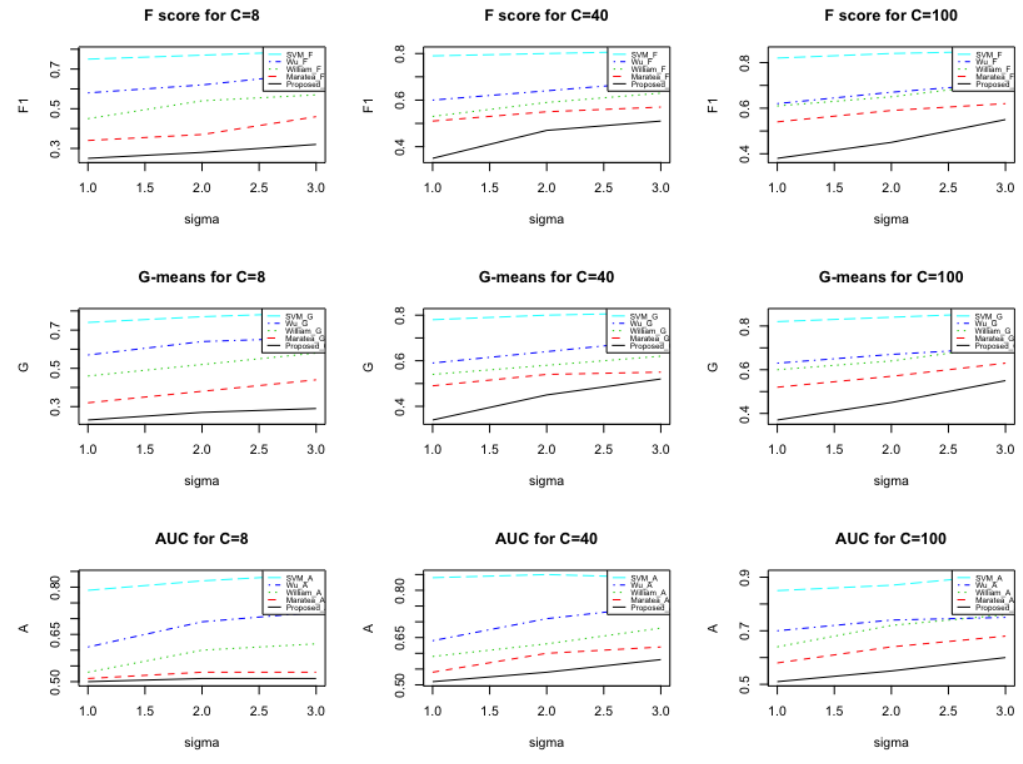
Figure 3. Performance of the competitor methods for Scenario